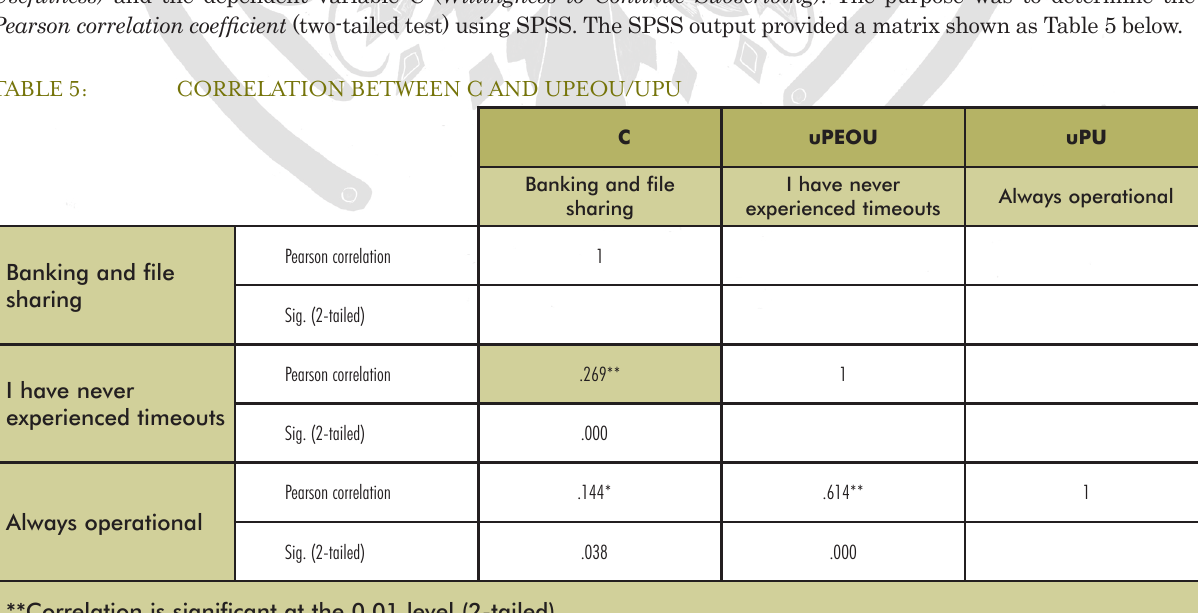
CORRELATION BETWEEN C AND UPEOU/UPU